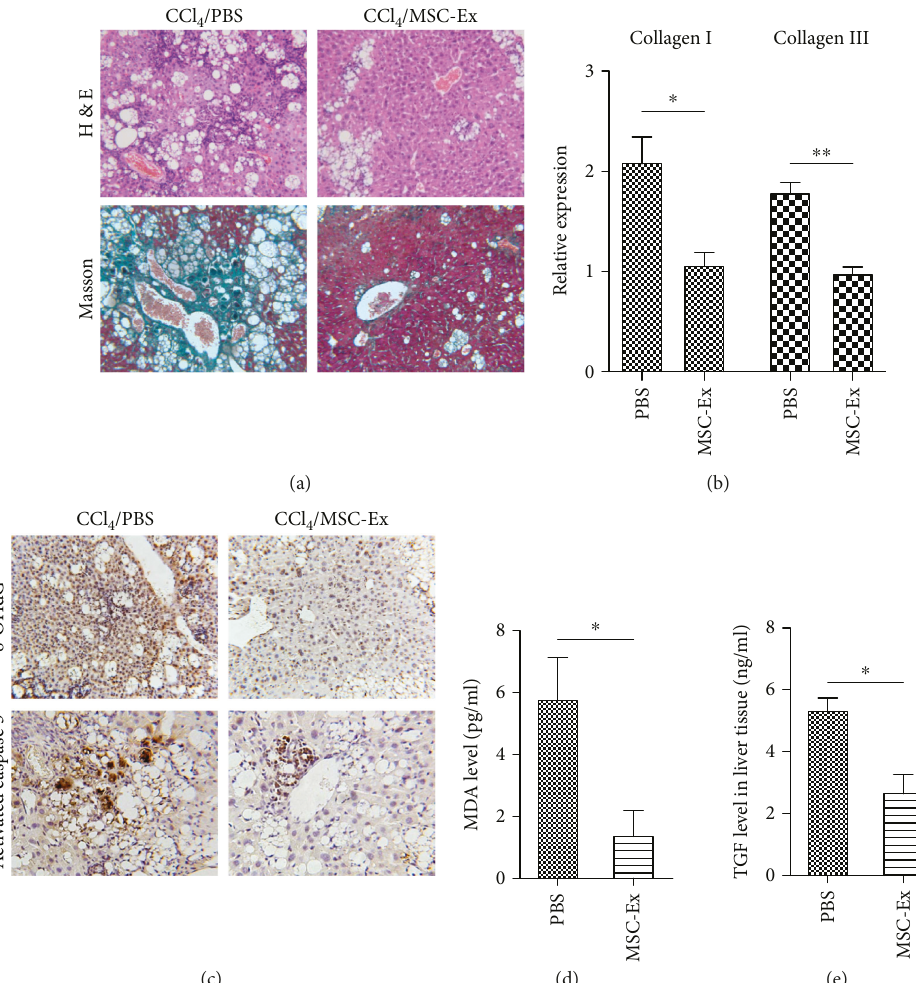
Figure 3: hucMSC-Ex reduced oxidative stress in mouse liver fi brosis. (a) Representative images of H&E and Masson staining of mouse fi brotic livers after PBS or hucMSC-Ex treatment. Reduced steatosis and collagen deposition were observed in the hucMSC-Ex group. Original magni fi cation 200x. (b) Quantitative analyses of collagen I and III mRNA expression after hucMSC-Ex treatment ( n = 10 ; ∗ P < 0 05 , ∗∗ P < 0 01 ). (c) Immunohistochemistry analysis of 8-OHdG and activated caspase 3 after administration of PBS or hucMSC-Ex. Original magni fi cation 200x. (d, e) MDA and TGF- β levels were measured in homogenates of a mouse fi brotic liver treated with PBS and hucMSC-Ex. The levels of MDA and TGF- β were inhibited by hucMSC-Ex compared with the PBS group ( n = 10 ; ∗ P < 0 05